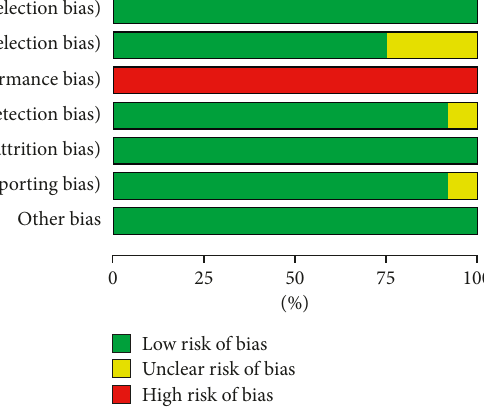
Figure 2: Risk of bias for each trial.